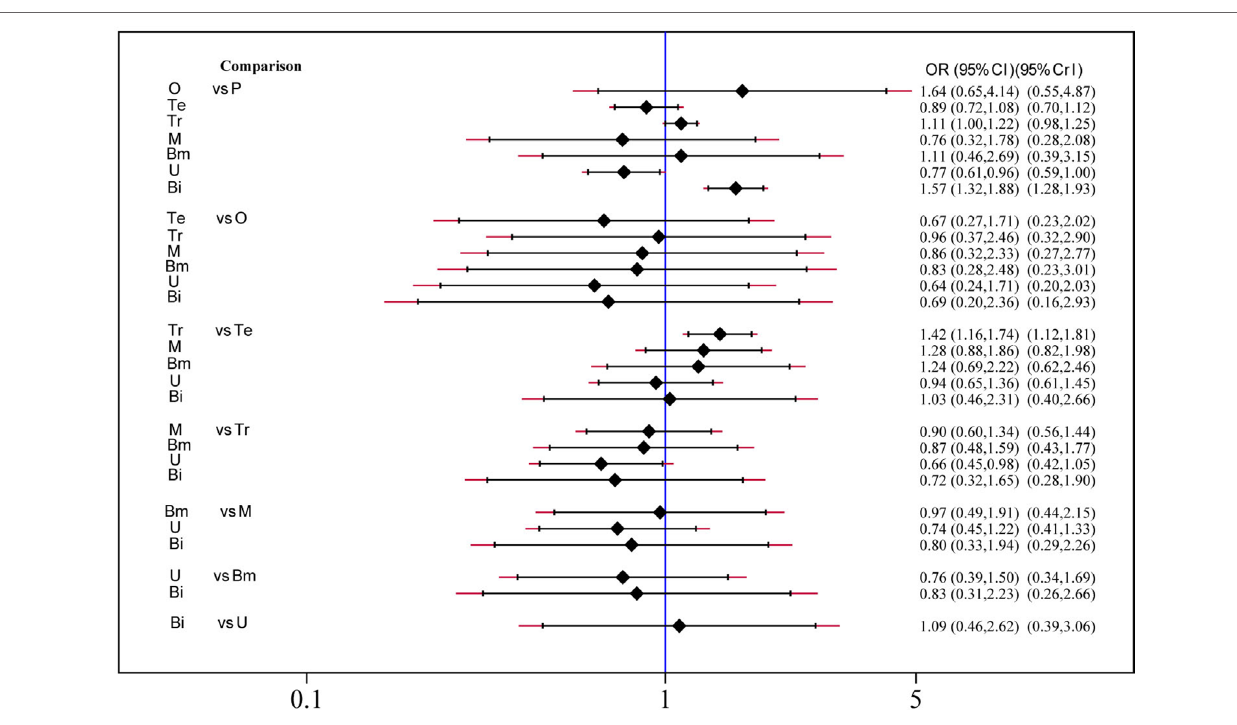
FIGURE 4 | Adverse events analysis of six treatment modalities. OR, odds ratio; CI, confidence interval; PrI, predictive interval; O, olcegepant; Te, telcagepant; Tr, triptan; M, MK3207; Bm, rimegepant (BMS-927711); U, ubrogepant; Bi, BI 44370; P,